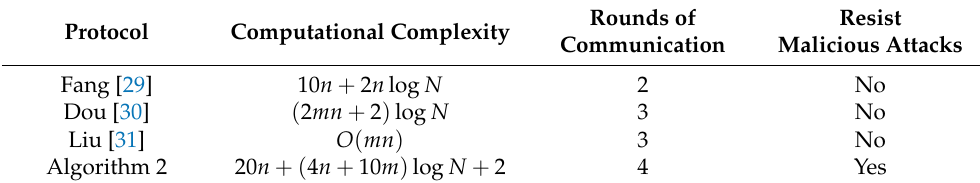
Table 2. Efficiency comparison (based on modular multiplication).